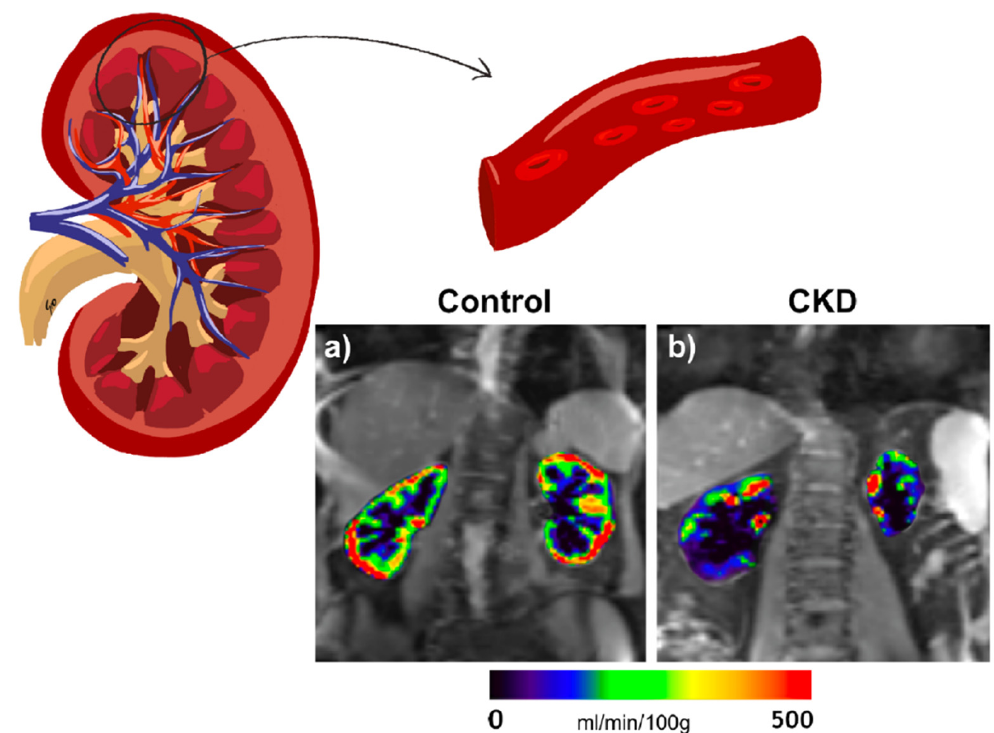
Figure 1. Representative RBF maps in a healthy volunteer (age 66 years) ( a ) and an individual with diabetes and CKD (age 76 years, eGFR 46 mL/min/1.73 m 2 ) ( b ). The color bar applies for both control and CKD. RBF maps of the kidneys are overlaid on the reference images (M0).